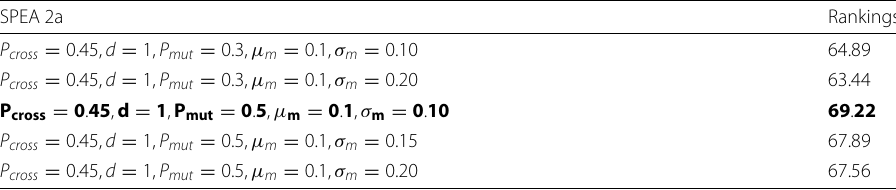
Table 5 Average rankings achieved by the Friedman test for the SPEA 2a algorithm with different parameter settings SPEA 2a Rankings